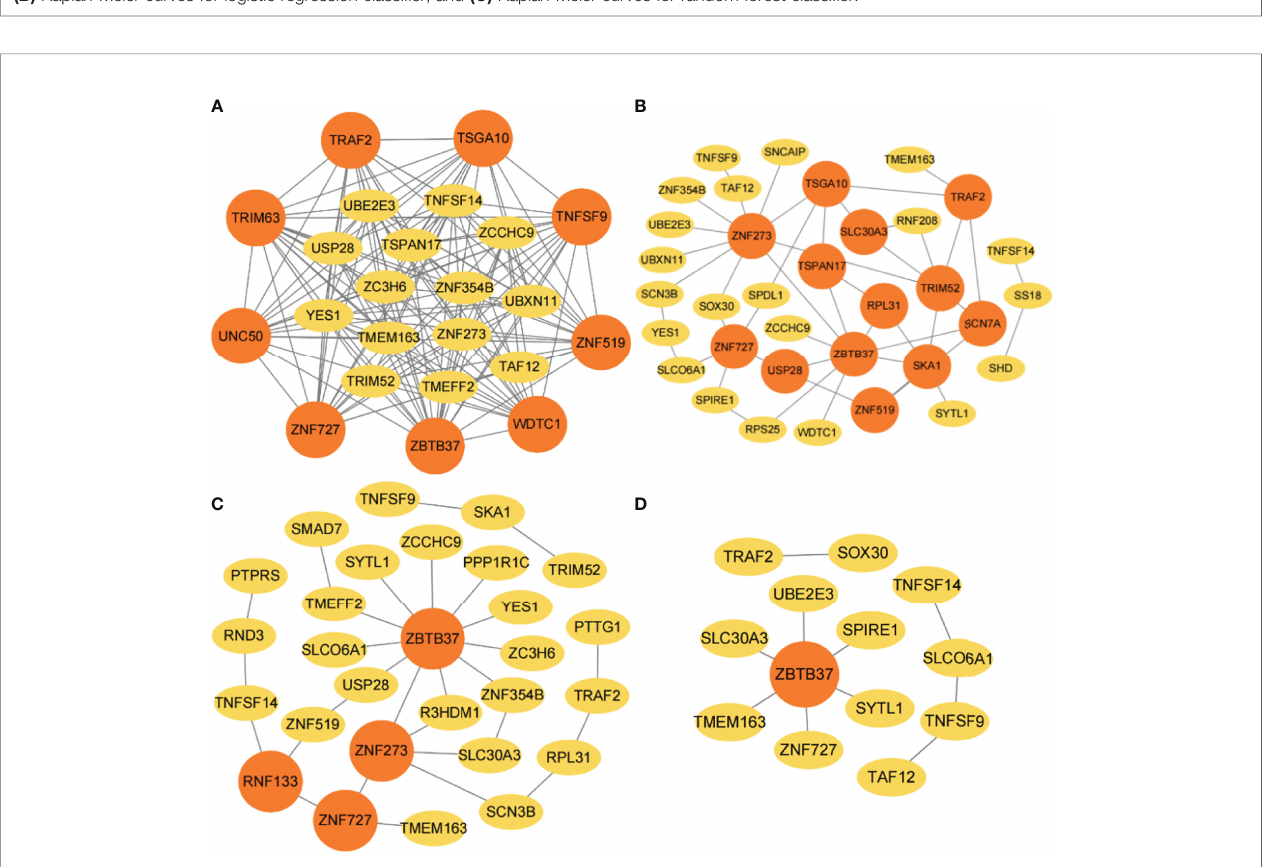
FIGURE 8 | The gene-gene interaction network in METABRIC. The selected interaction networks for (A) 1-year, (B) 3-year, (C) 5-year, and (D) 10-year categories. The orange circular nodes represent hub